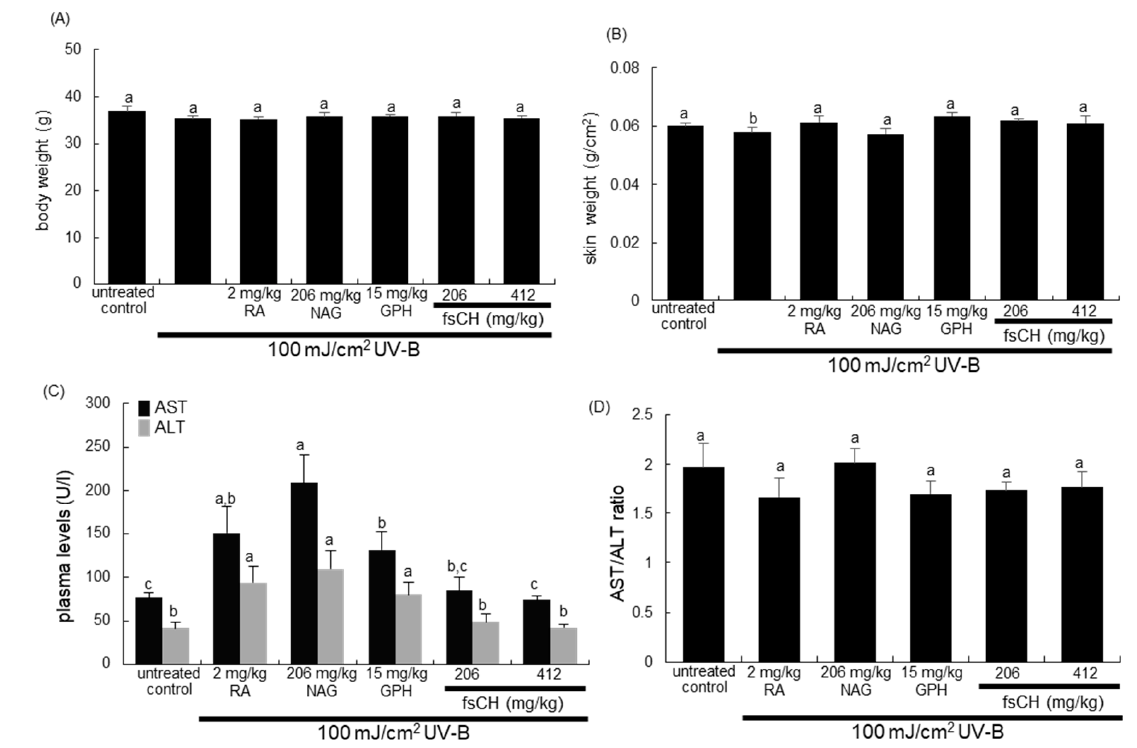
Figure 2. Body and skin weights ( A , B ), and the serum levels ( C ) and ratio ( D ) of aspartate aminotransferase (AST) and alanine aminotransferase (ALT) of SKH-1 hairless mice. SKH-1 hairless mice were exposed to UV-B three times a week while being treated with 2 mg/kg retinoic acid (RA) intraperitoneally and 206 mg/kg N-acetyl-D-glucosamine (NAG), 15 mg/kg glycine-proline-hydroxyproline tripeptide (GPH), and 206–412 mg/kg Pangasius hypophthalmus fish skin hydrolysates (fsCH) orally for eight weeks. The ultraviolet-B irradiation intensity increased weekly by 1 MED up to 3 MED until the eighth week and total irradiation intensity was 63 MED inflicted to mice during eight weeks. Respective values ( n = 15) in bar graphs not sharing a small letter are different at p < 0.05.